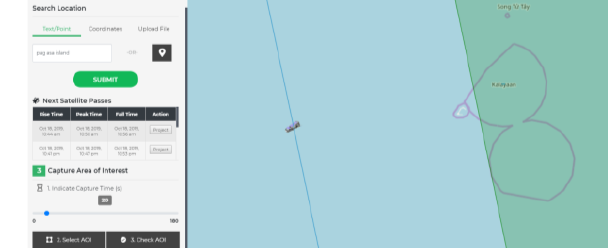
Figure 2.b. Projection of the right-looking projection of the NovaSAR-1 satellite in 30m ScanSAR